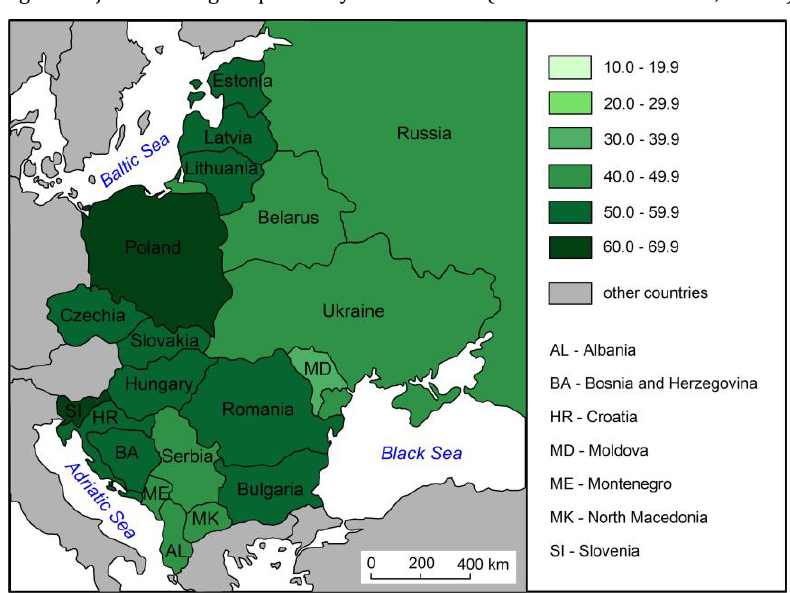
Fig. 4. Projected old-age dependency ratio in 2050 (Source: United Nations,